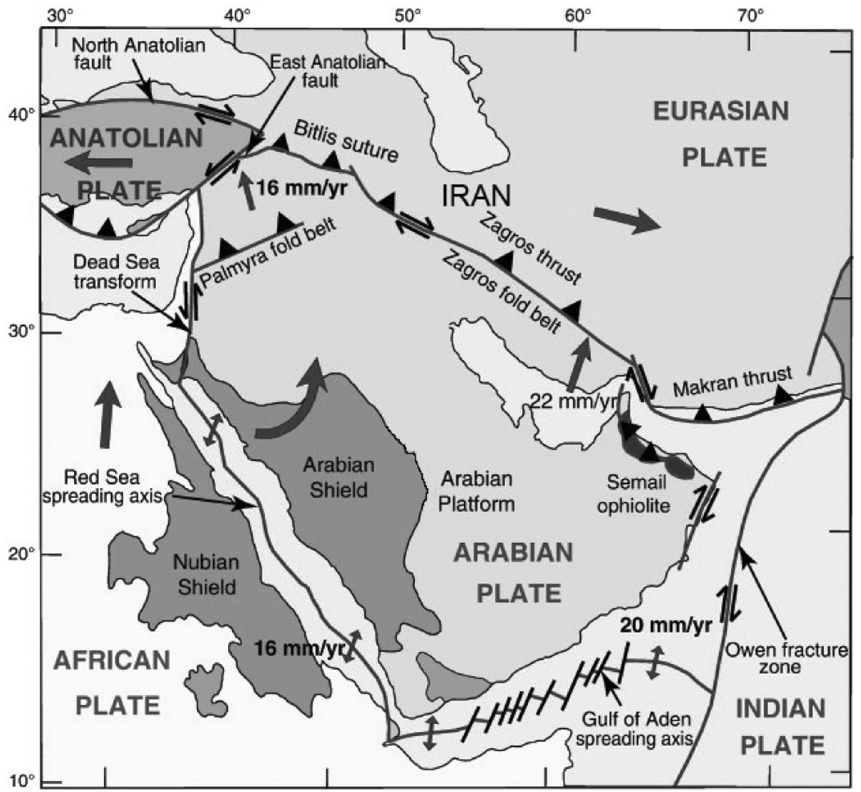
Figure 1. A simplified map showing the situation of the Zagros and the Eurasian and Arabian plates. In this schematic figure, plate boundaries, approximate plate convergence vectors, and some key geologic features are mapped for a better understanding of the tectonic situation of the region 31 .